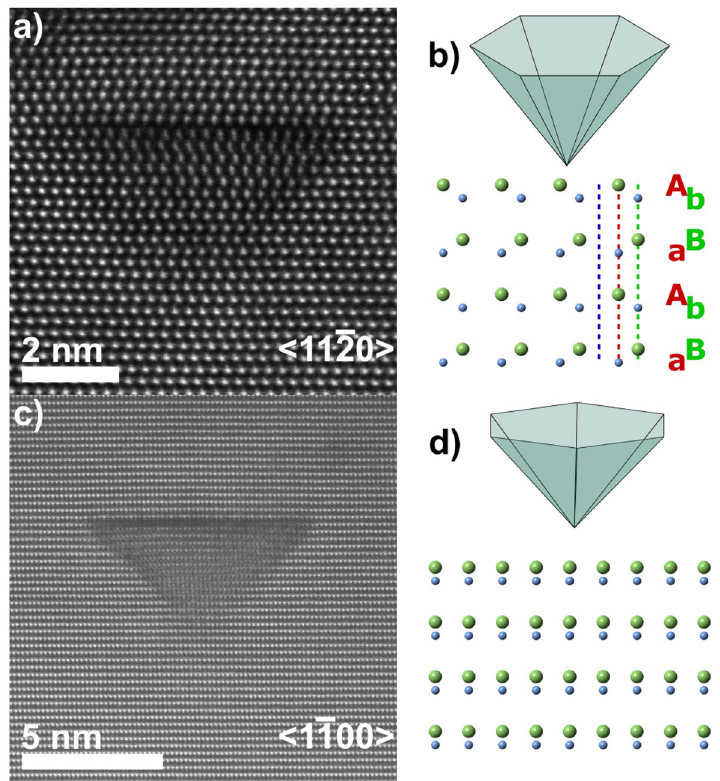
Figure 2. Lattice resolved view of wurtzite (WZ) GaN and the pyramidal defect with a schematic representation of the defect and GaN lattice, viewed along < 11 ¯ 20 > in ( a ) and ( b ) and along < 1 ¯ 100 > in ( c ) and ( d ). The schematic pyramids are slightly tilted towards the viewer to illustrate the orientation of the hexagonal shape. For the model structures, Ga is light green, and N is light